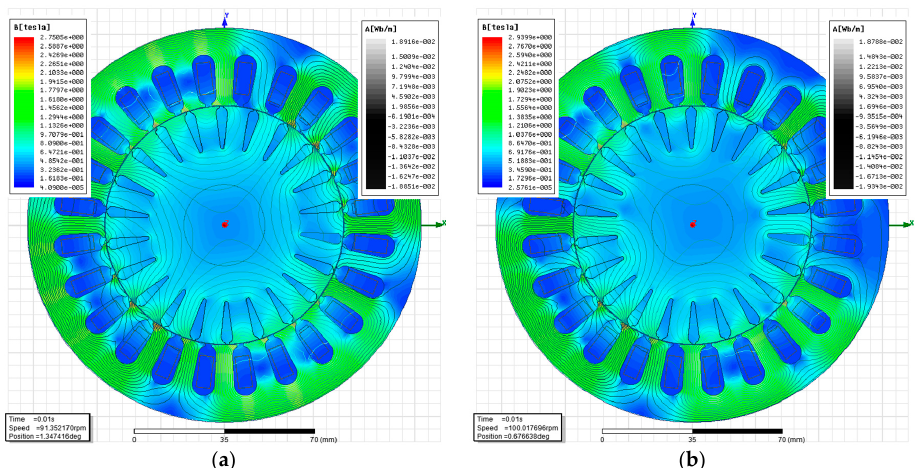
Figure 3. Magnetic field distributions at time equal to 10ms, load torque T L =T N , and number of shorted turns: ( a ) N f = 1 and ( b ) N f = 40.